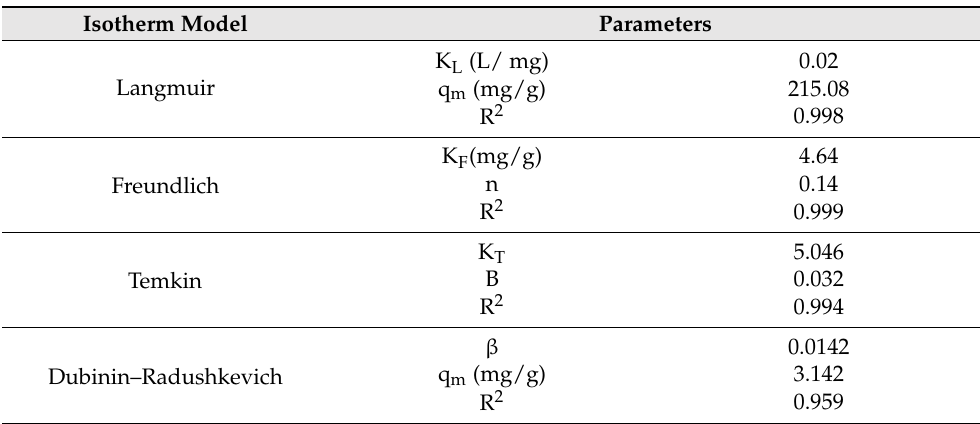
Table 2. Equilibrium parameters of fitting to various isotherm